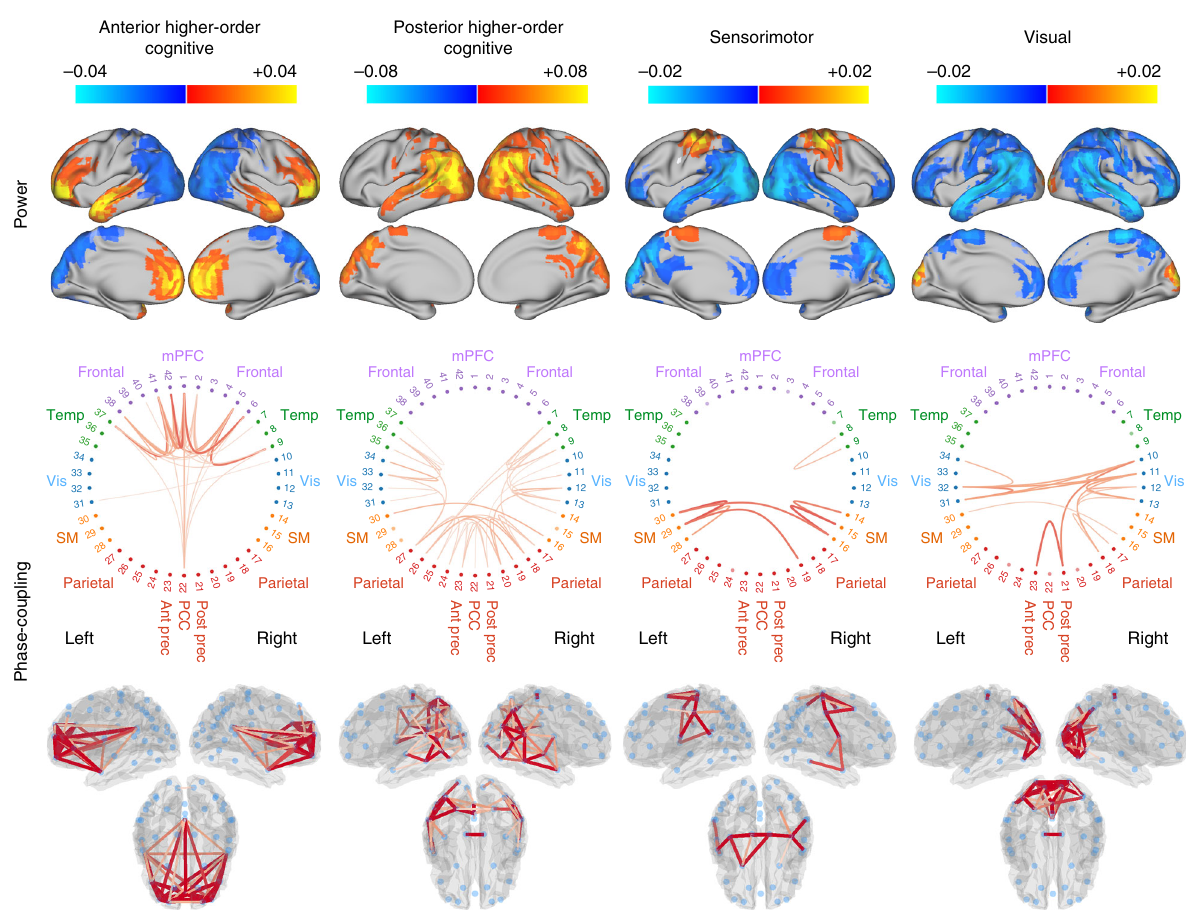
Fig. 2 Brain states identi fi ed using Hidden Markov Modelling represent networks of spectral coherence. Wideband (1 – 30 Hz) thresholded power maps and phase-coupling are displayed for the two higher-order cognitive (anterior and posterior) states and the visual and motor states. The two higher-order cognitive networks contain regions that suggest a subdivision of the default mode network. Power maps are relative to the temporal average, i.e. they are globally centred such that blue colours re fl ect power that is lower than the average over states and red/yellow colours re fl ect power that is higher than the average over states. The coherence networks only show high-valued connections (see Methods). In the circular phase-coupling plots, each numbered dot represents one brain region. Supplementary Fig. 1 shows the same information for the other eight